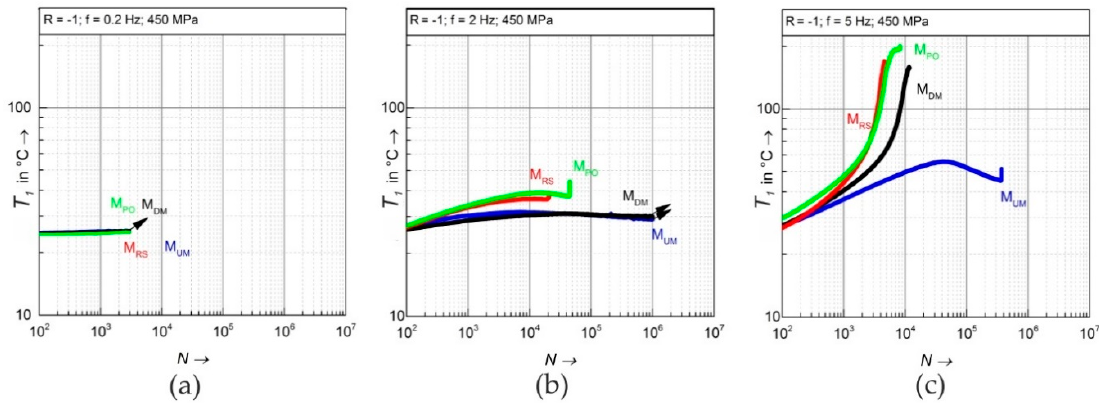
Figure 9. Development of absolute temperatures T 1 in the gage length for stress controlled fatigue tests with: ( a ) f = 0.2 Hz; ( b ) f = 2 Hz; ( c ) f = 5 Hz. Metals 2018 , 8 , x FOR PEER REVIEW